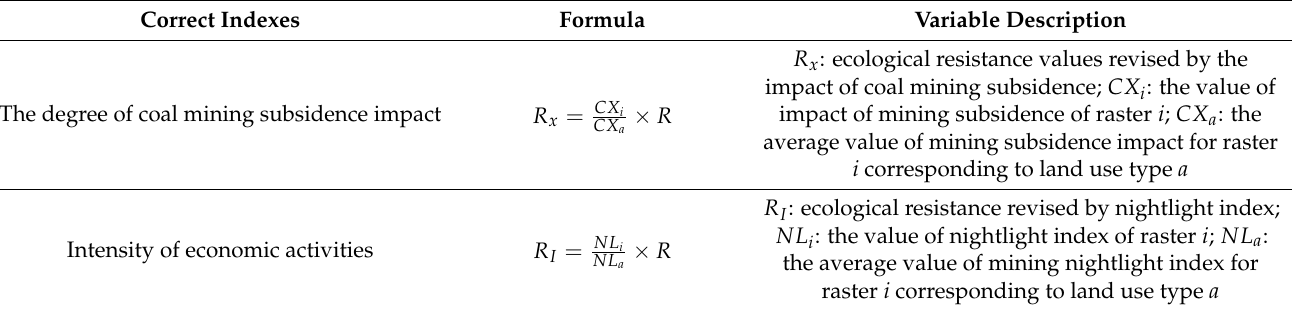
Table 3. Revising framework of “coal mining subsidence-economic